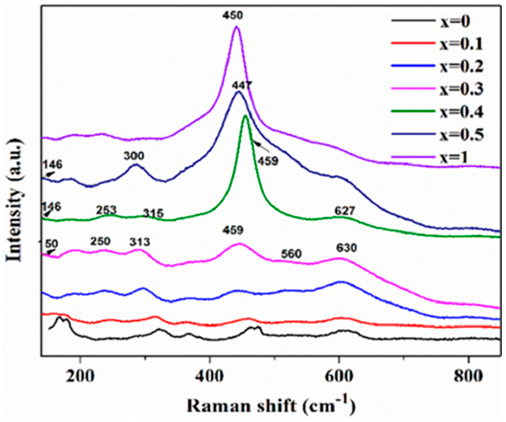
Figure 2. Raman spectra of Ce x Zr 1 − x O 2 .